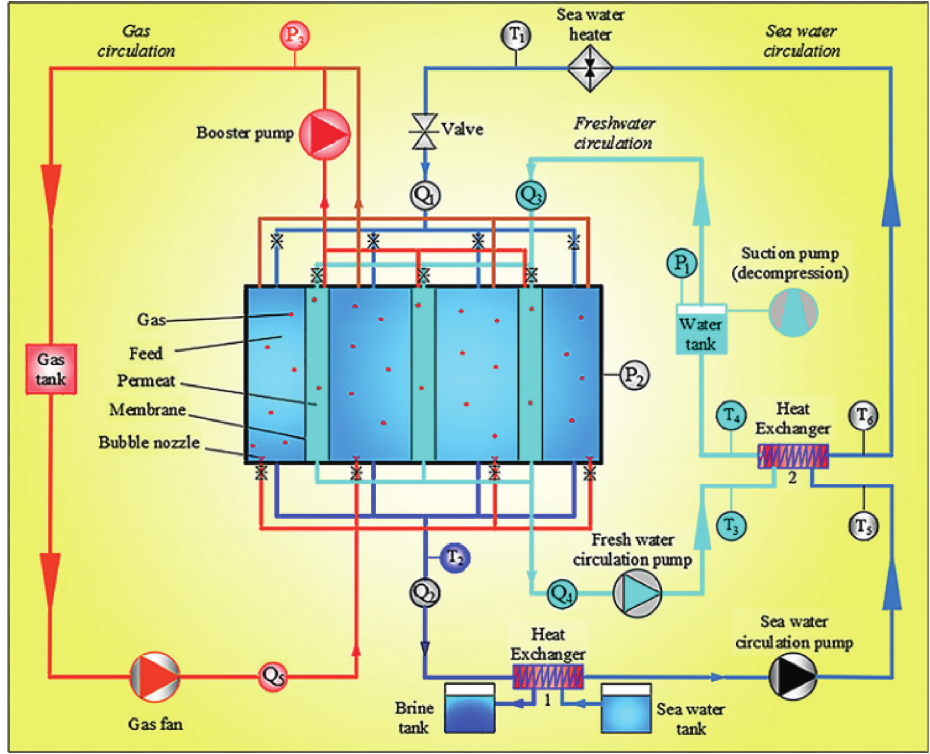
Figure 1: Flow chart of the seawater desalination process based on BVDCMD. T 1 ∼ T 6 : the temperature of feed inlet, feed outlet, permeate outlet, permeate inlet, and inlet and outlet of heat exchanger 2, respectively. P 1 ∼ P 3: the pressure of freshwater, seawater, and gas. Q 1 ∼ Q 5: the flow rate of feed inlet, feed outlet, permeate inlet, permeate outlet, and gas